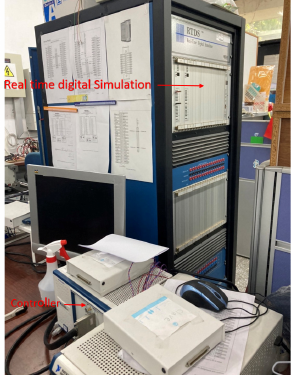
Figure 15. The experimental test bench.